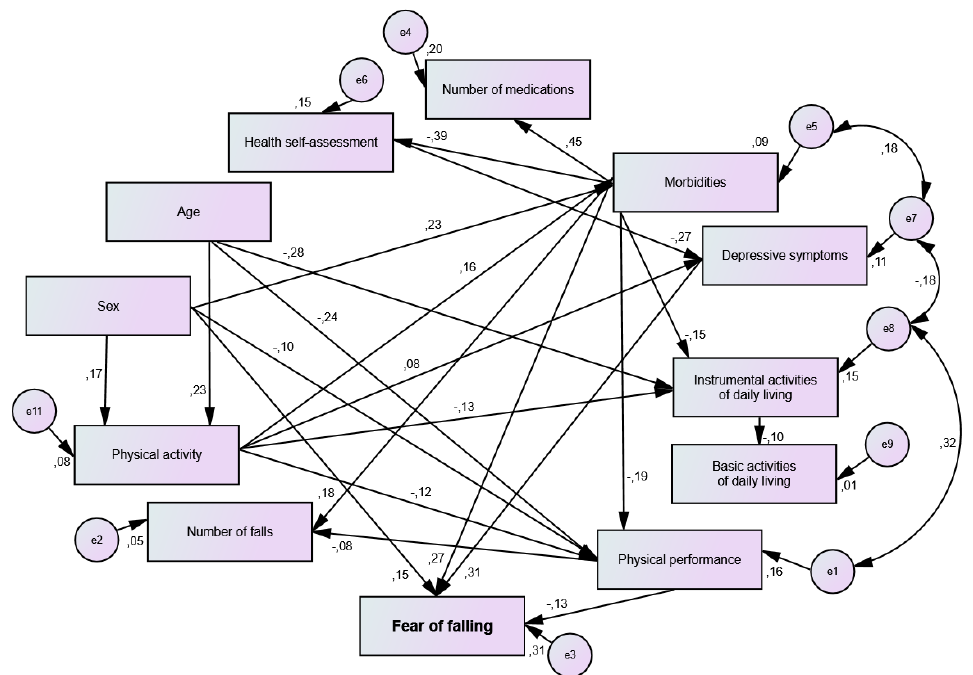
Figure 2. Model for analyzing the association between socioeconomic, clinical, and health charac- teristics and fear of falling among community-dwelling older adults (Macapá, AP, Brazil, 2017) ( n = istics and fear of falling among community-dwelling older adults (Macap á , AP, Brazil, 2017) ( n = 410). 410). (χ 2 (gl = 41) = 54.78; p = 0.073; CFI = 0.95; GFI = 0.99; TLI = 0.93; RMSEA = 0.029).